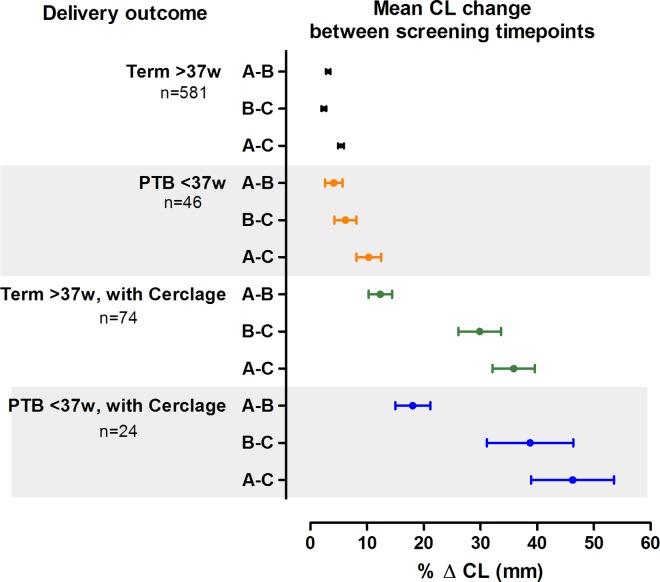
Mean difference in CL (mean % Δ CL) between time-points A: 13+0–15+6 weeks, B: 16+0–18+6 weeks, C: 20+0–22+6 weeks (A-B, B-C, and A-C) according to delivery outcome and cerclage insertion. In women receiving a cerclage, mean CL started above 25mm at timepoint A, and went on to shorten, most significantly at timepoint C. The greatest difference in CL is observed between timepoints B-C and A-C in those that received a cerclage and went on to deliver preterm <37weeks, followed by term delivery with a cerclage. (% ΔCL = percentage change in CL (mm) between screening time points; PTB = preterm birth <37 weeks; Screening time points = A: 13+0–15+6 weeks, B: 16+0–18+6 weeks, C: 20+0–22+6 weeks; SD = standard deviation; Term = birth >37 weeks; W = weeks).